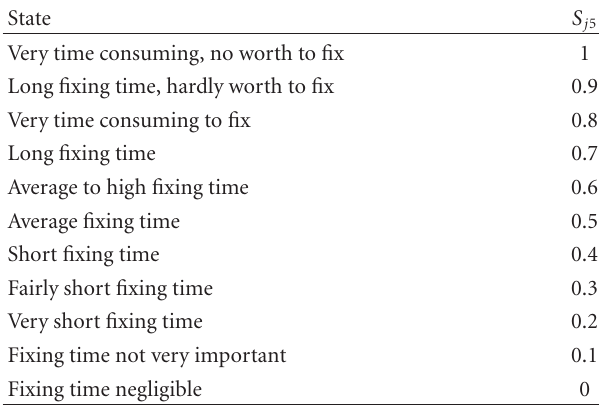
Table 8: Classification of repairing time of a failure